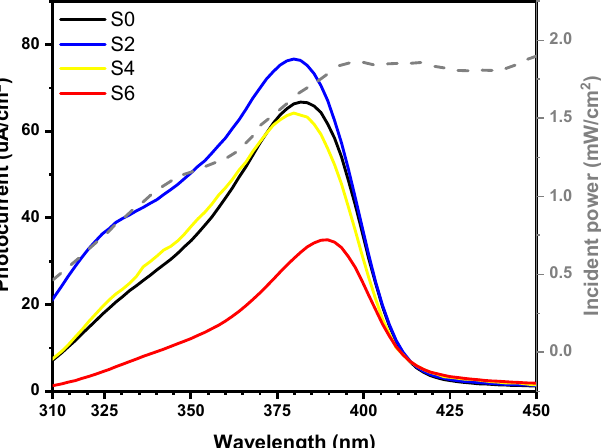
Figure A2. Photocurrent vs. irradiation wavelength curves measured for samples S0, S2, S4 and S6 (left ordinate axis) and corresponding light power (right ordinate axis).